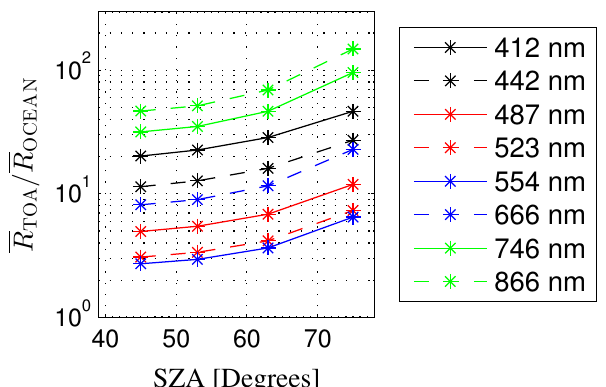
Figure 8. Effects of SZA on the TOA radiance contribution from the ocean. R TOA and R OCEAN are the average TOA radiance and average radiance from the ocean,